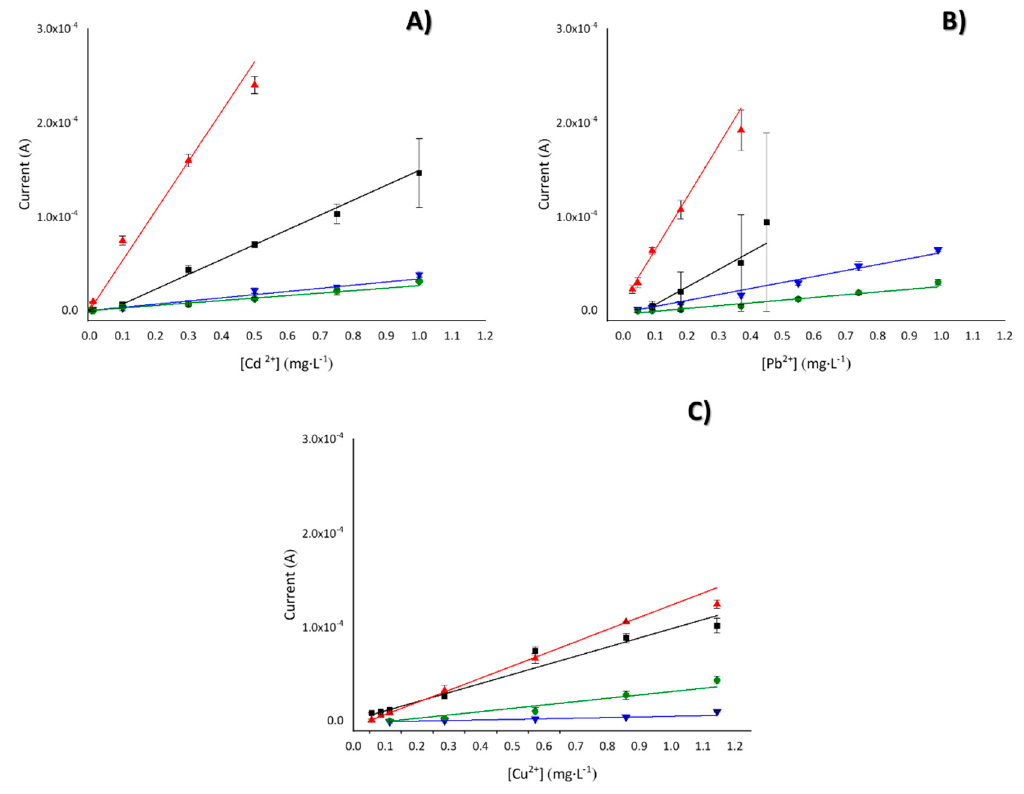
Figure 4. Calibration curves of Cd 2+ ( A ), Pb 2+ ( B ) and Cu 2+ ( C ) using the four different electrodes under study ■ 20% graphite; ▲ Hg-NPs Route A ; ▼ Hg-NPs Route B ; ● Hg-NPs Route B /PDDA. The experi- under study (cid:4) 20% graphite; (cid:78) Hg-NPs Route A ; (cid:72) Hg-NPs Route B ; • Hg-NPs Route B /PDDA. The exper- mental error was estimated as the standard deviation ( n = 3). imental error was estimated as the standard deviation ( n = 3).